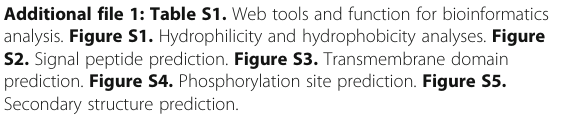
coupled receptor; PCR: Polymerase chain reaction; gDNA: